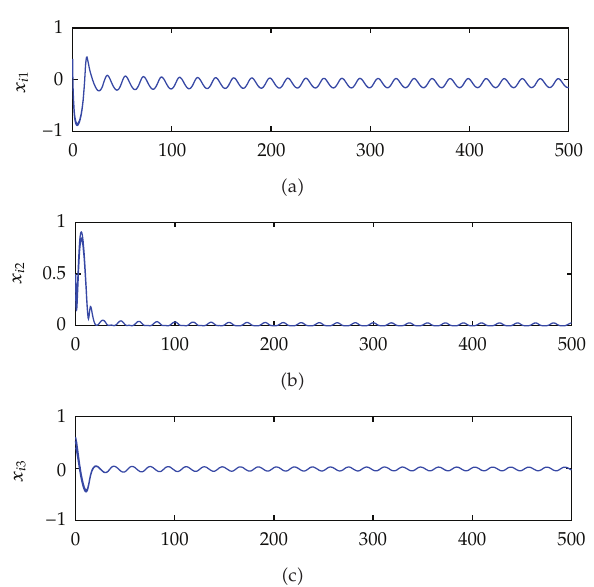
Figure 1: State trajectories x ir (cid:2) t (cid:3)(cid:2) 1 ≤ i ≤ 3 , 1 ≤ r ≤ 3 (cid:3) of network (cid:2) 4.1 (cid:3) without